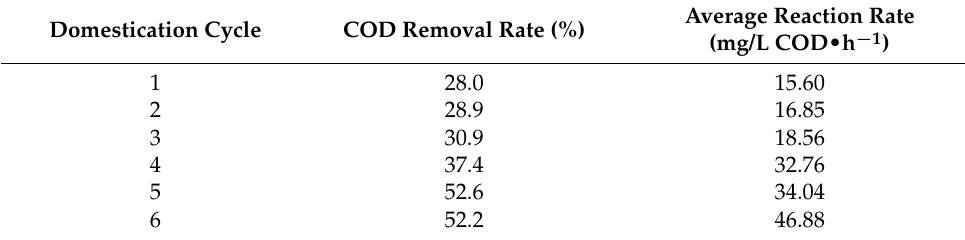
Figure 1. COD change at each acclimation stage of activated sludge. Table 2. Changes in the degradation rate and average reaction rate of the COD during the acclima- tion.